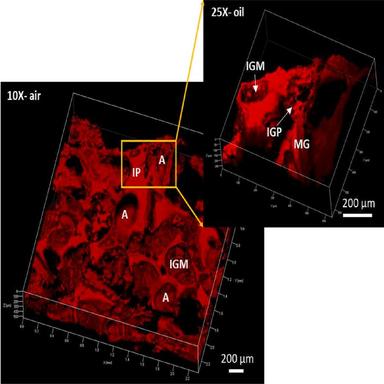
3D visualization of the z-stacked confocal images of an etched pore cast of IL; the solid represents the pore space and the etched away grains are black. The sample was imaged using two different objectives. Left: 10X air (NA = 0.3). Right: 25X oil immersion (NA = 0.8). A: allochem, MP: macroporosity, IGM: intragranular microporosity, IGP: intergranular porosity, and MG: microporous grain.